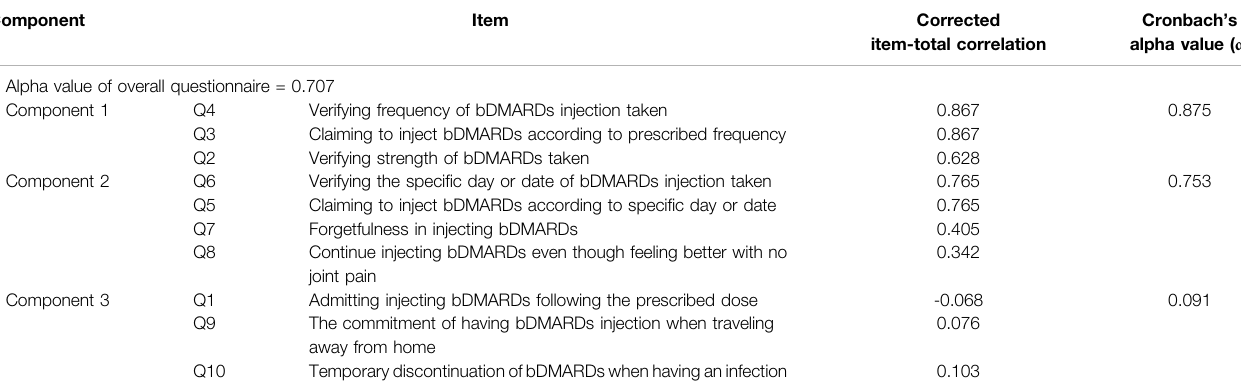
TABLE 5 | Reliability test and corrected item-total correlation of SCADS questionnaire based on the three-component solution obtained. Component Item Corrected